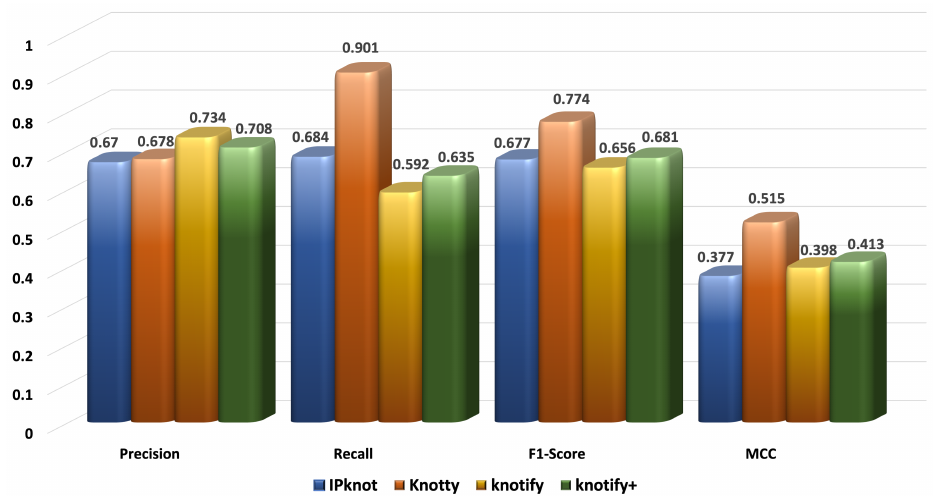
Figure 9. Metrics for the sequences of length ≥ 50.